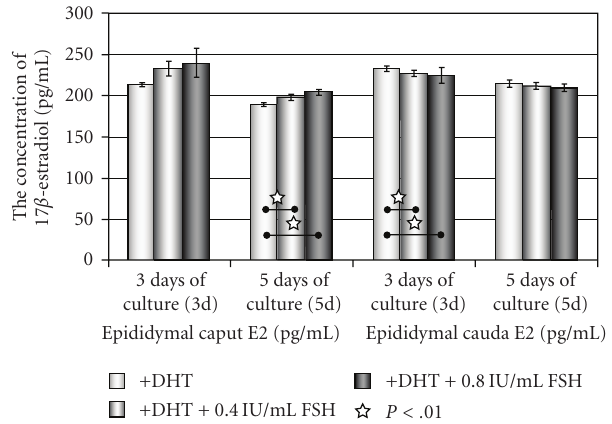
Figure 6: The concentration of 17 β -estradiol (E2) in media of epithelial cells of the caput and cauda epididymis cultured with DHT and stimulated with